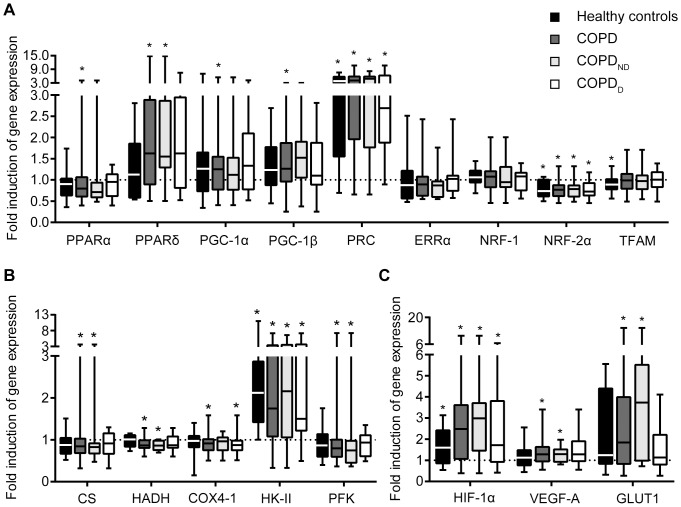
Gene expression responses to exercise are not significantly different between COPD patients and healthy controls, regardless of desaturation status.
A Gene expression inductions (post/pre) for regulators of Oxphen. PPAR, peroxisome proliferator-activated receptor; PGC, PPAR gamma co-activator; PRC, PGC-1-related co-activator; ERRα, estrogen-related receptor α; NRF, nuclear respiratory factor; TFAM, mitochondrial transcription factor A. B Gene expression inductions for metabolic enzymes involved in citric acid cycle, β-oxidation and glycolysis. CS, citrate synthase; HADH, 3-hydroxyacyl-CoA dehydrogenase; COX4-1, cytochrome c oxidase subunit IV isoform 1; HK-II, hexokinase II; PFK, phosphofructokinase muscle isoform. C Gene expression inductions of hypoxia-associated targets. HIF-1α, hypoxia-inducible factor 1 alpha; VEGF-A, vascular endothelial growth factor A; GLUT1, glucose transporter 1. Whiskers indicate minimum and maximum values. Level of significance: *p<0.05 for post vs. pre.